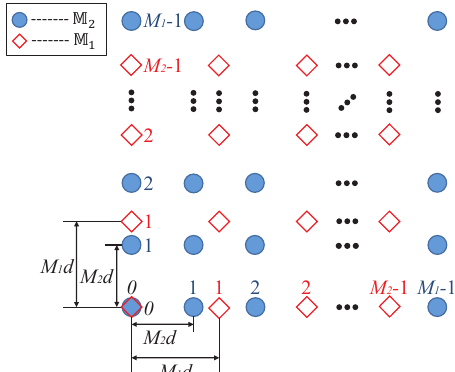
Figure 1. The prototype planar coprime array